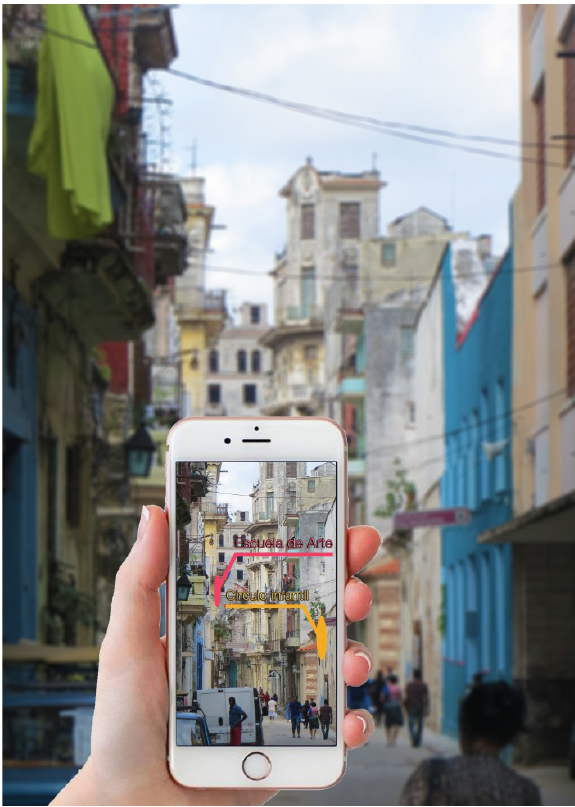
Figure 6. Example of an application of aumented reality